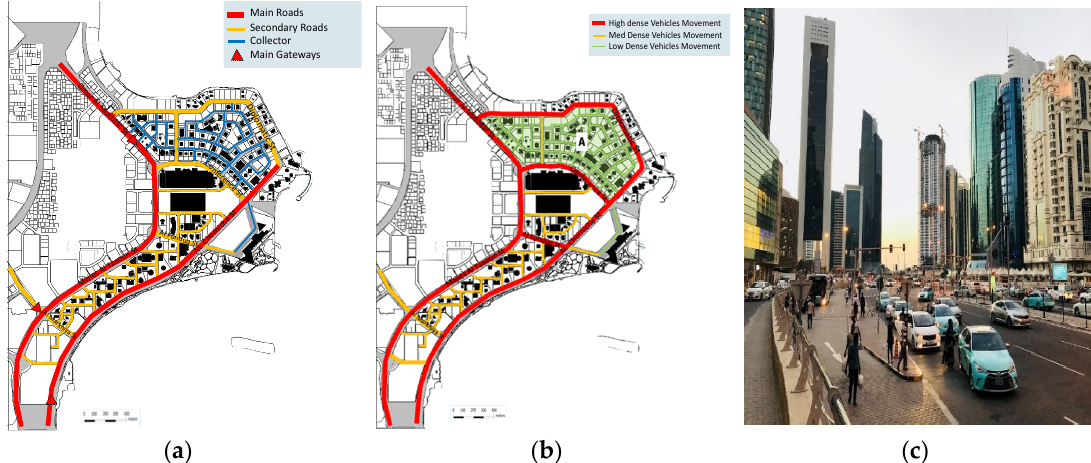
Figure 8. ( a ) West Bay Doha street network map; ( b ) West Bay Doha vehicle movement; ( c ) taxi station next by the city center shopping center.